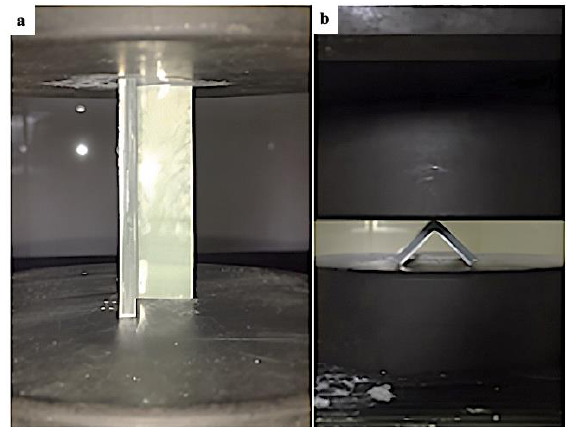
Figure 1. ( a ) Axial and ( b ) lateral specimen position.